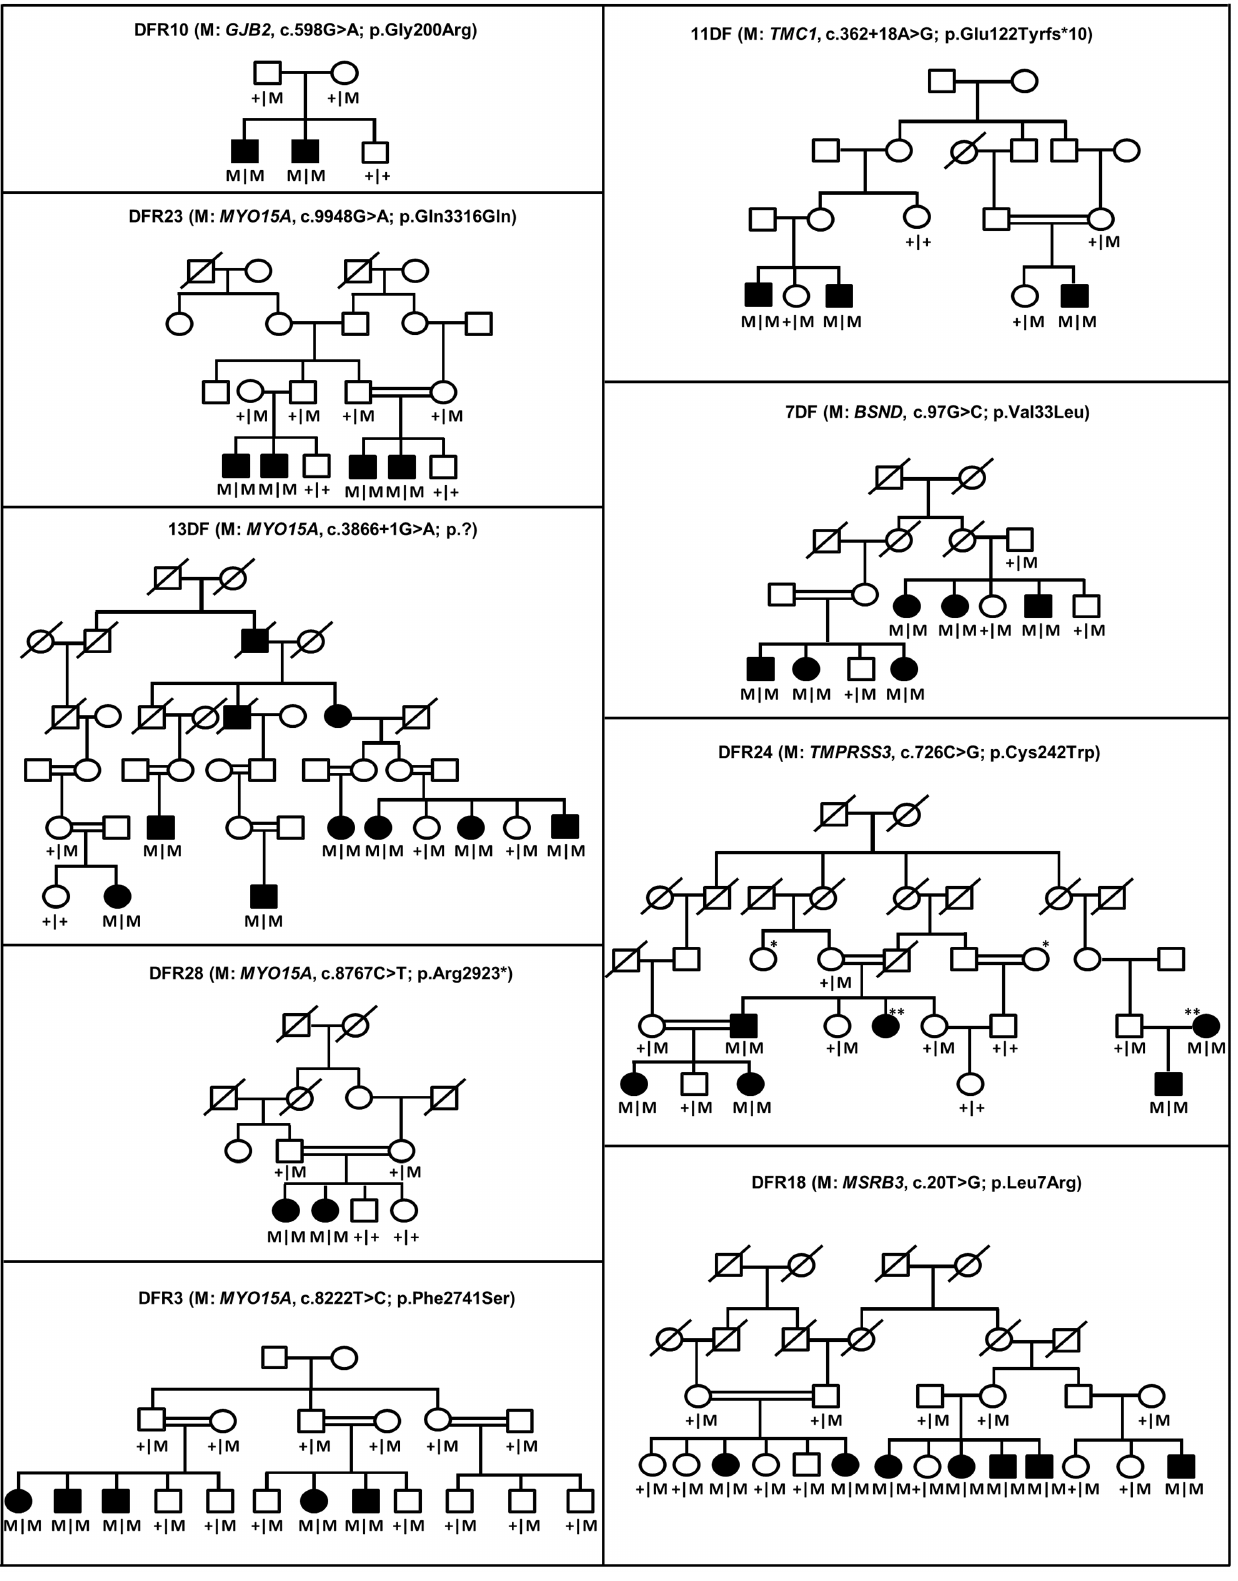
Figure 1. Pedigrees and the segregation of novel mutations in known deafness genes. Unfilled circles indicate unaffected females, unfilled squares indicate unaffected males, filled circles indicate affected females, filled squares indicate affected males, double lines represent consanguineous marriages, slashed line across the symbols indicate deceased individual, + indicates wild type allele, M indicates mutant allele. doi:10.1371/journal.pone.0100146.g001 PLOS ONE |